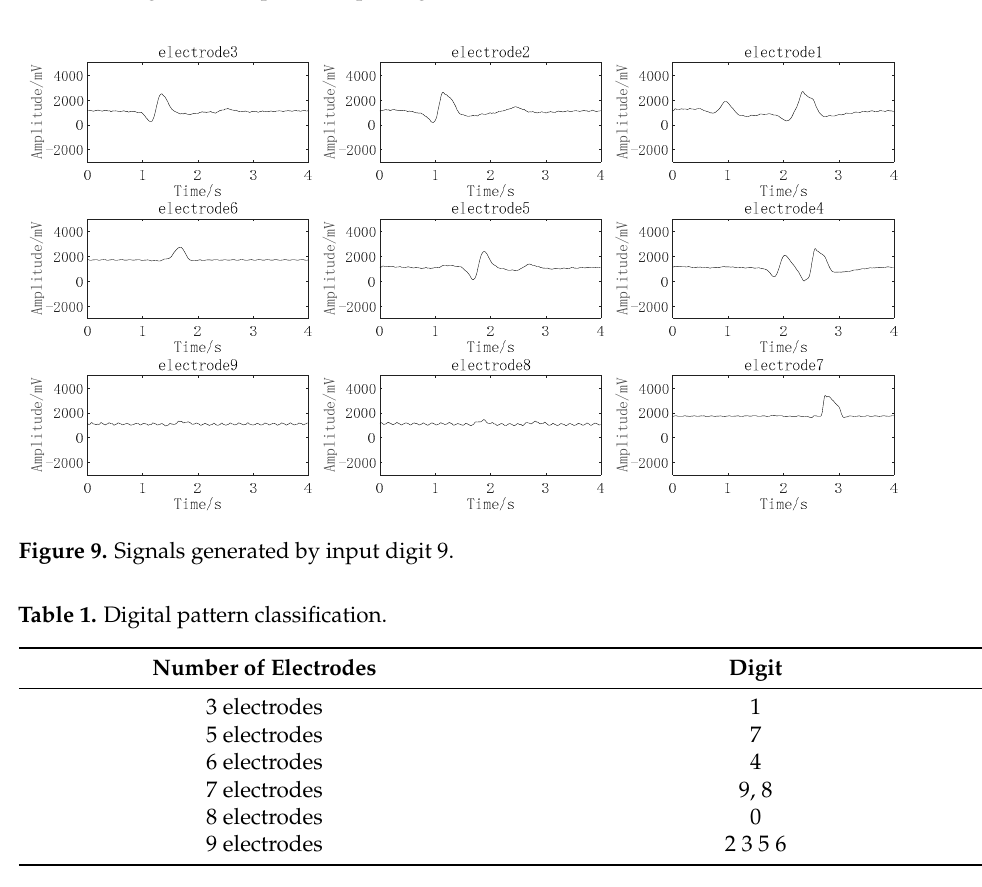
Figure 8. Finger motion path of input digit 9.